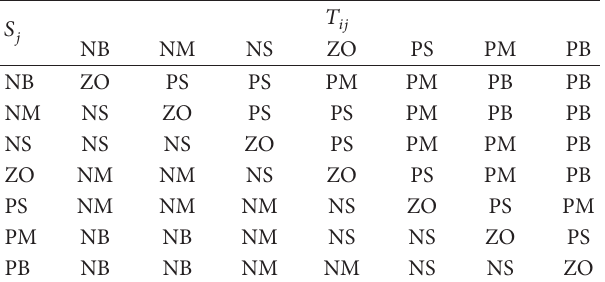
Table 1: Resource scheduling table based on fuzzy